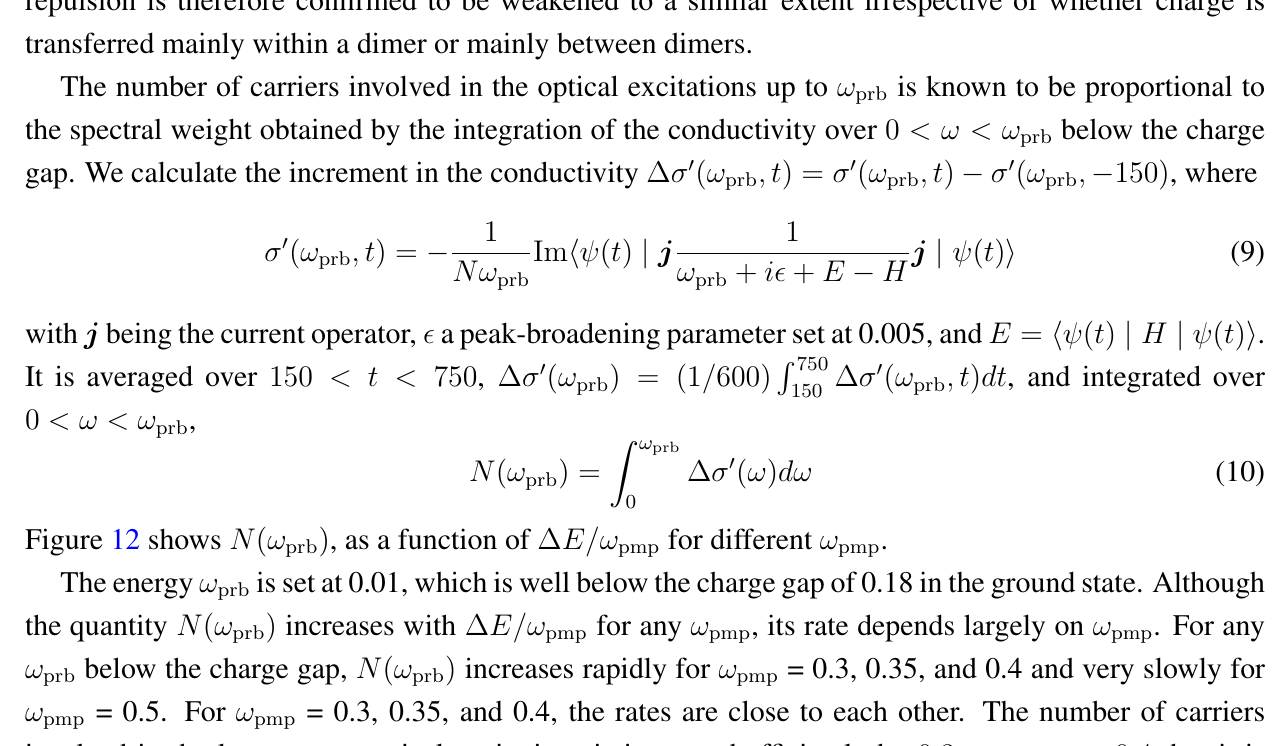
, as a function of the number dim , for different ω From [16]. Reproduced with permission pmp pmp